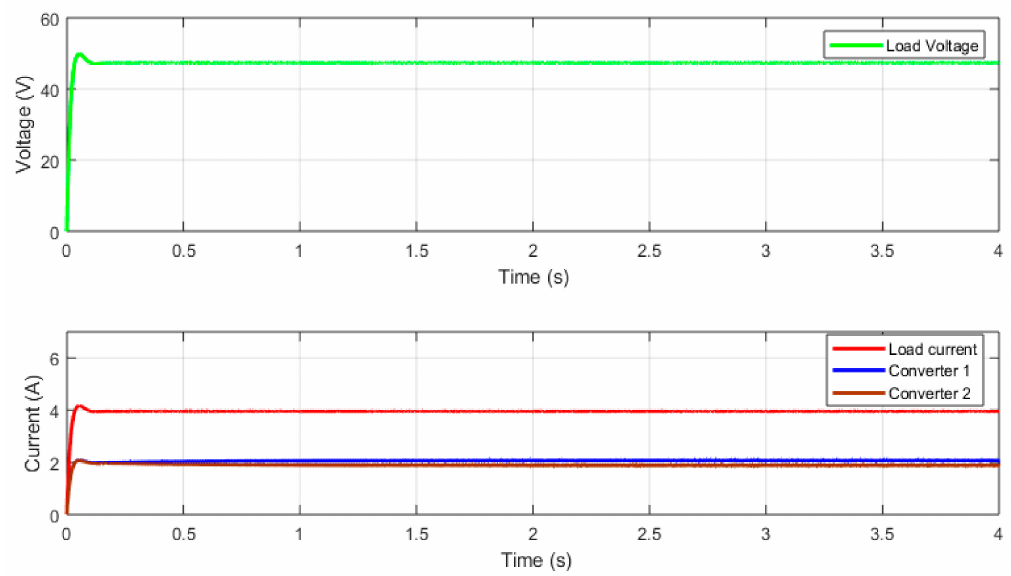
Figure 12. Simulation results for different cable resistances for proposed droop control: load voltage, converter output currents and load